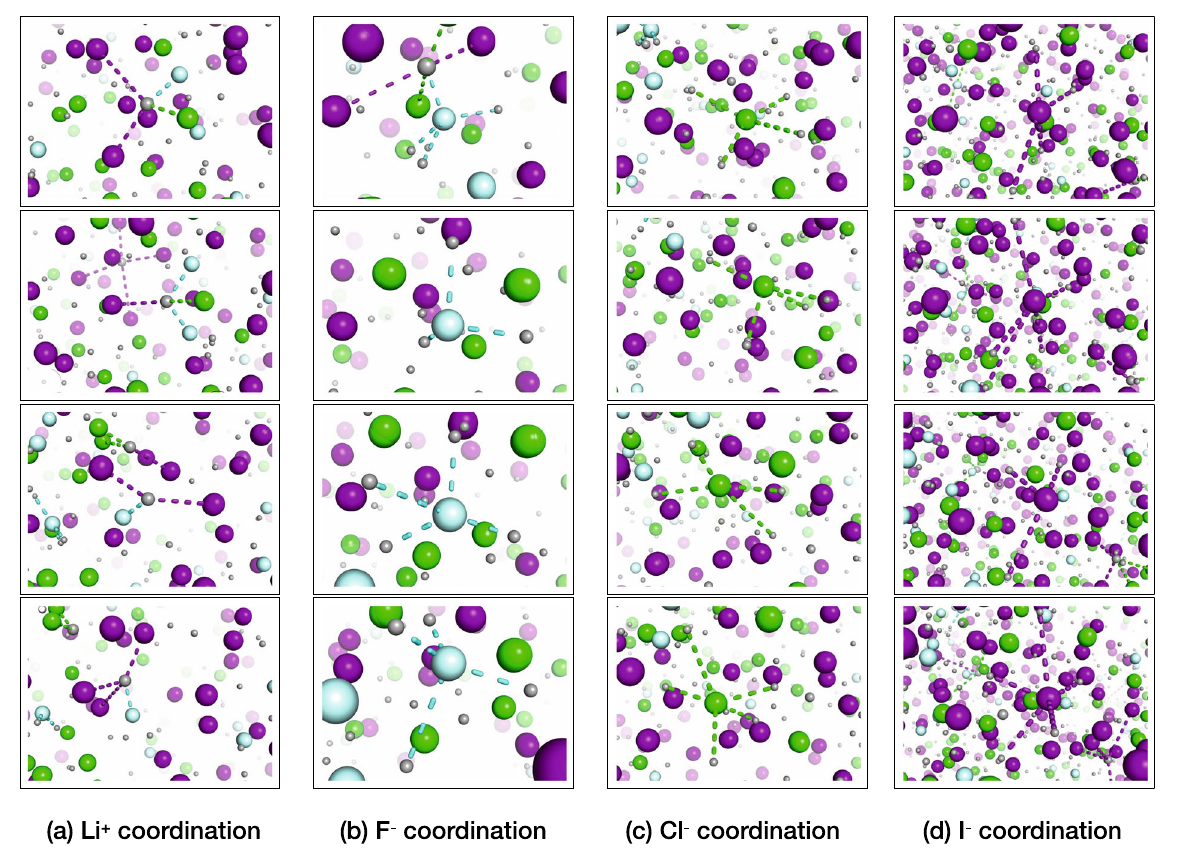
Fig. 3 Snapshots of LiF-LiCl-LiI eut at 1200 K. a Li + coordination, b F − coordination, c Cl − coordination, and d I − coordination. In gray: Li + , light blue: F − , green: Cl − , and purple: I − . For visibility, only a few selected coordination spheres are indicated. Ionic bonds are indicated as dashed lines for the fi rst coordination shell; the bonds were selected as distances that are smaller than the fi rst minima in the respective cation – anion radial distribution